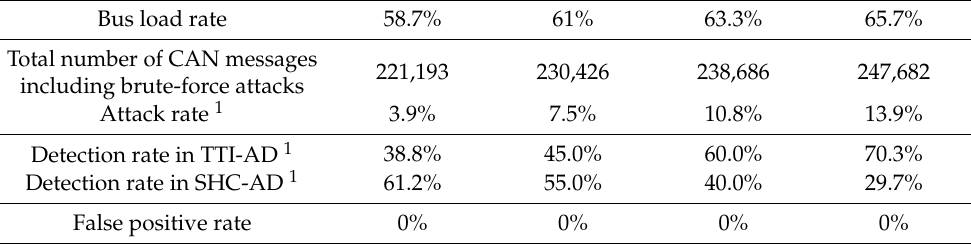
Table 6. Detection performance against brute-force attacks as a function of the bus load rate.